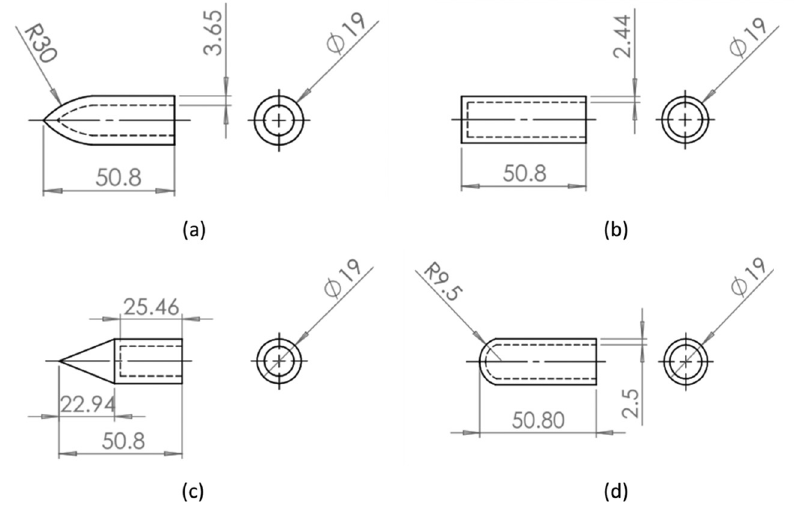
Figure 2: Dimension for ( a ) ogive, ( b ) blunt, ( c ) conical, and ( d ) hemispherical projectile shape ( in mm )